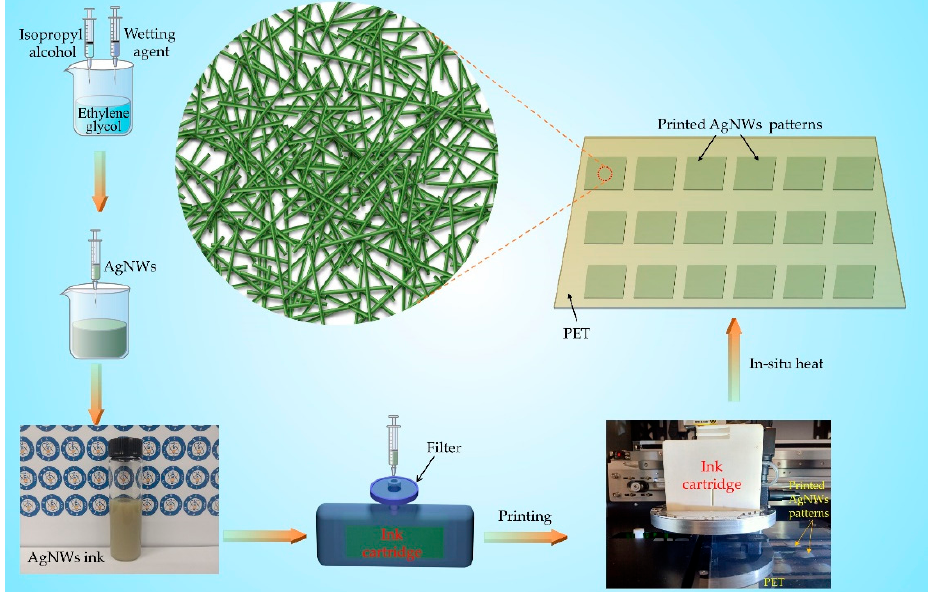
Figure 1. Schematic diagrams of the fabrication process of AgNWs conductive ink, process of inkjet printing, and magnified mode of AgNWs-FTCF in the